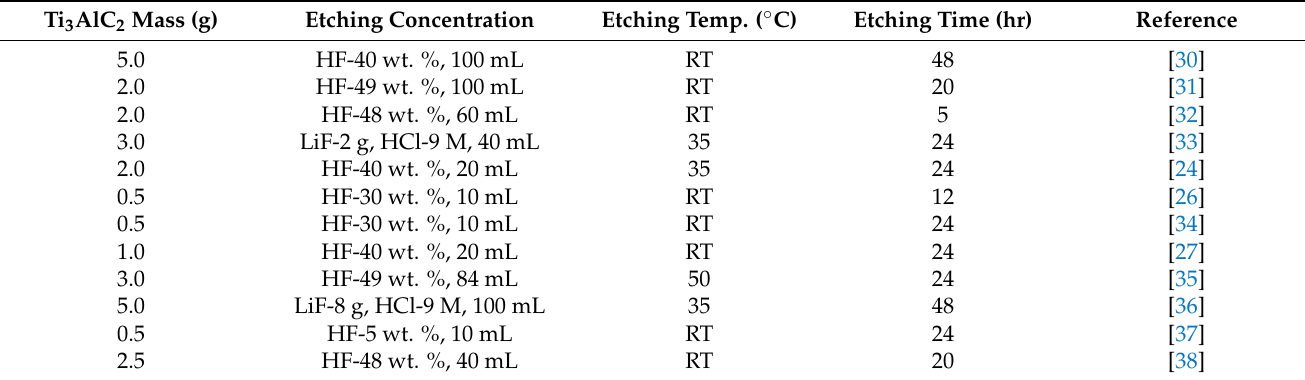
Table 1. The recent development of etching treatment using HF and